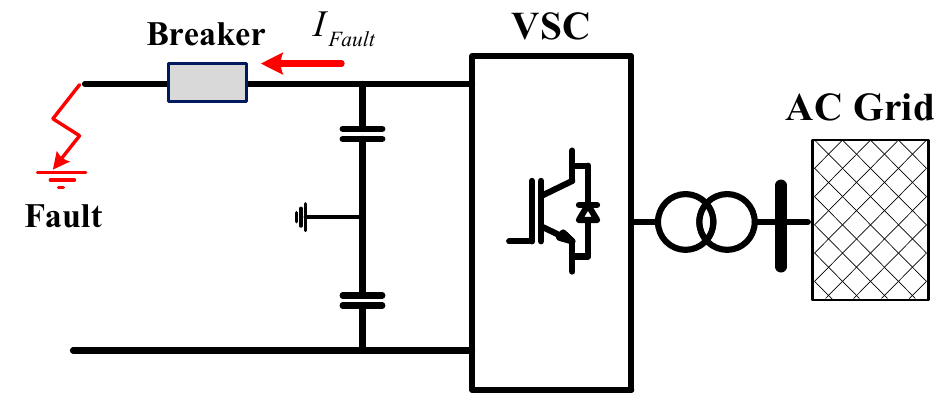
Figure 4. Simulated diagram of a DC system and a DC breaker.